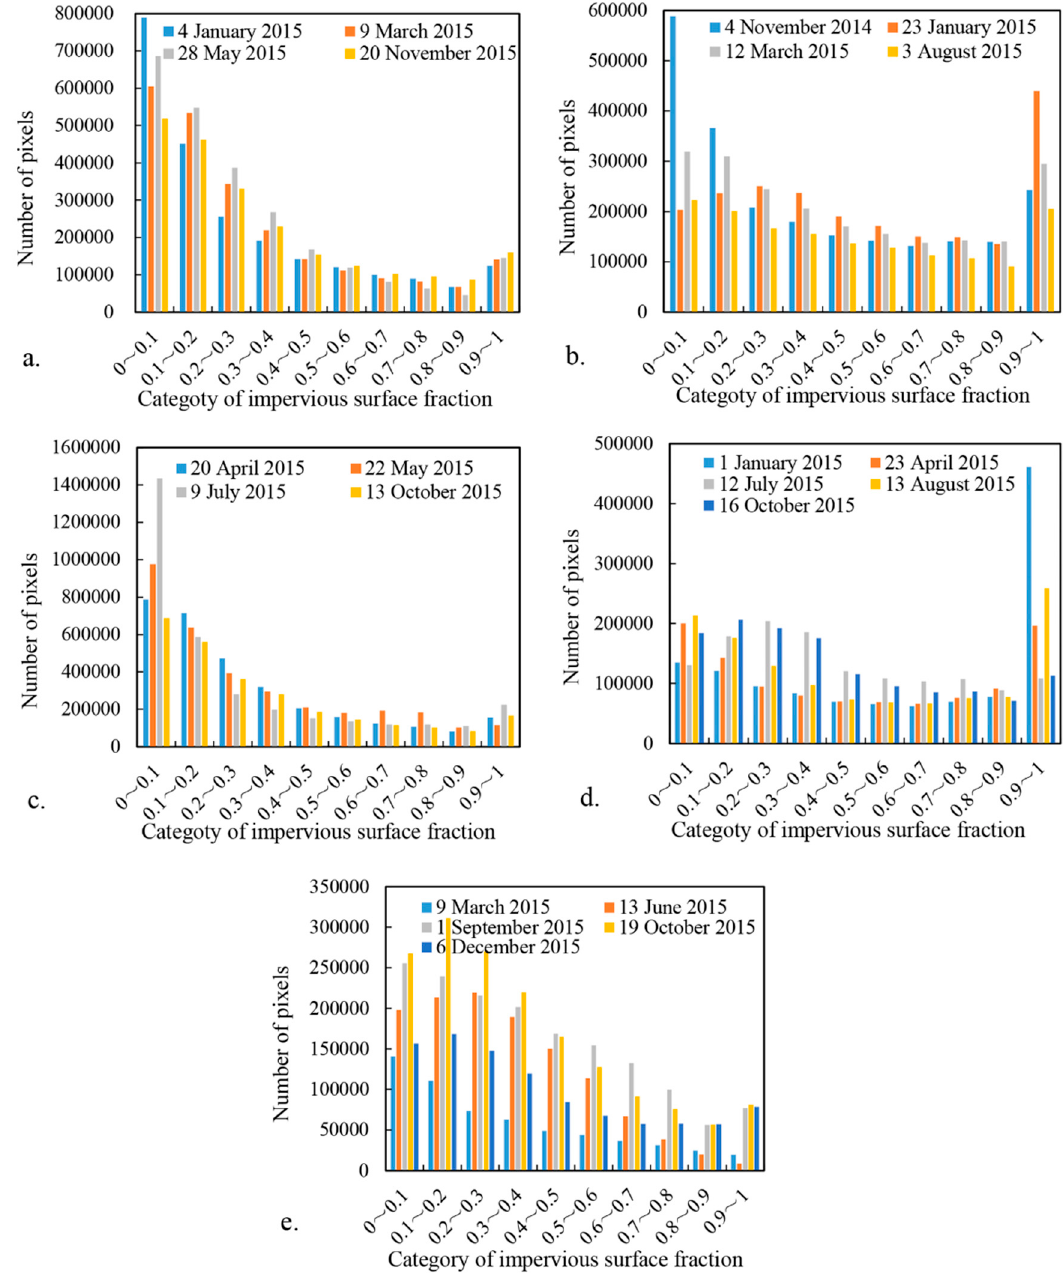
Figure 6. Number of pixels representing impervious surfaces based on a 0.1 interval: ( a ) Kunming, ( b ) Ningbo; ( c ) Sheyang; ( d ) Shijiazhuang; and ( e )